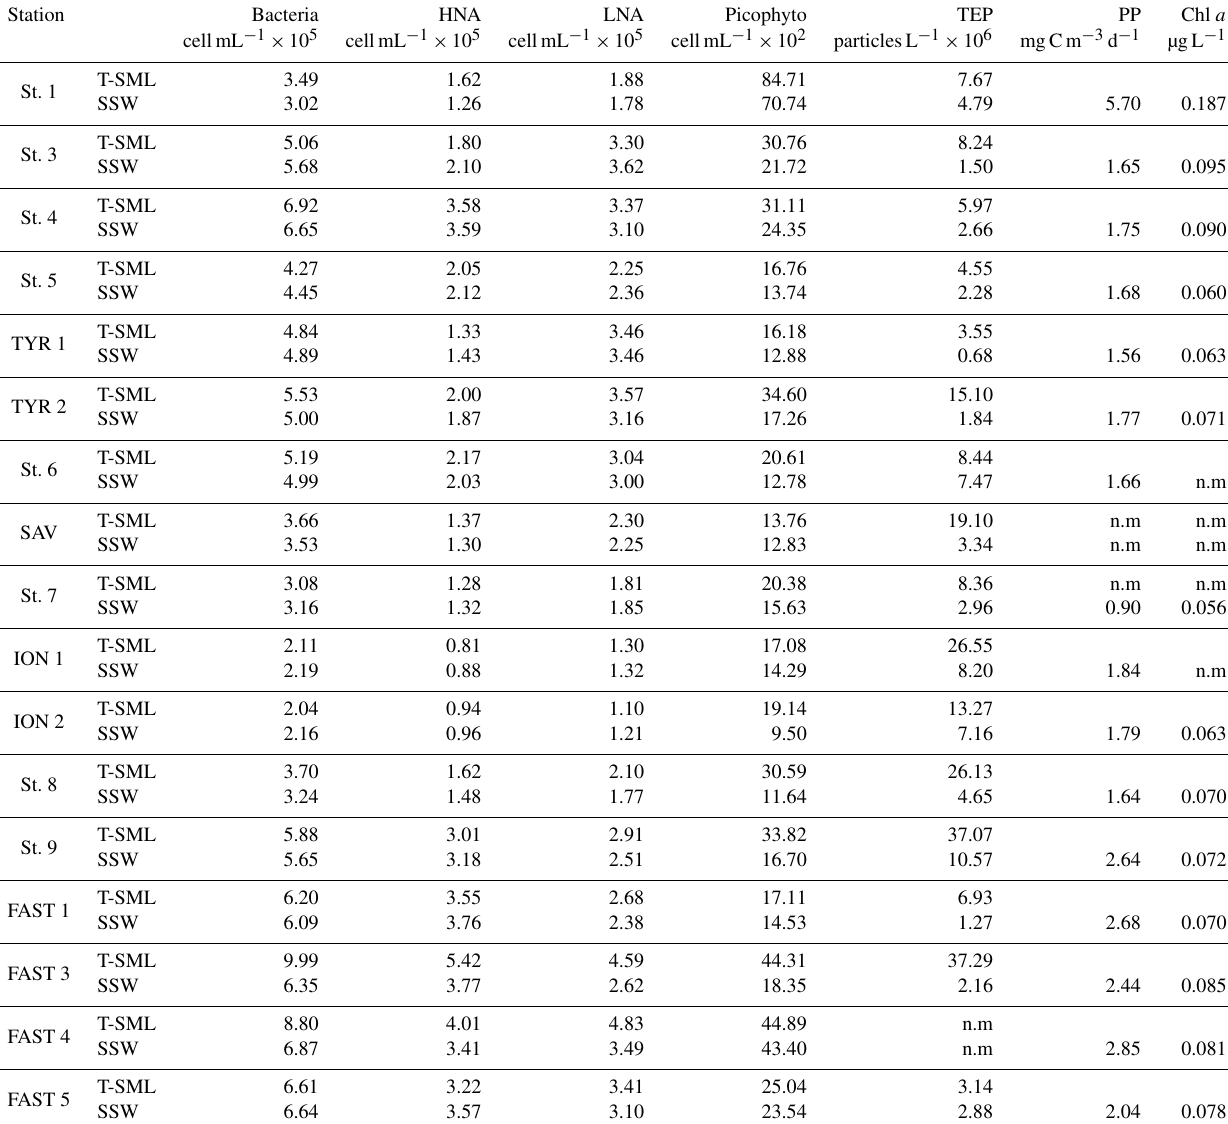
Table 2. Biological parameters measured at all stations: bacteria; high-nucleic-acid-content bacteria: HNA; low-nucleic-acid-content bacte- ria: LNA; picophytoplankton; transparent exopolymer particles: TEPs; primary production: PP; and chlorophyll a : Chl a . n.m: not measured.